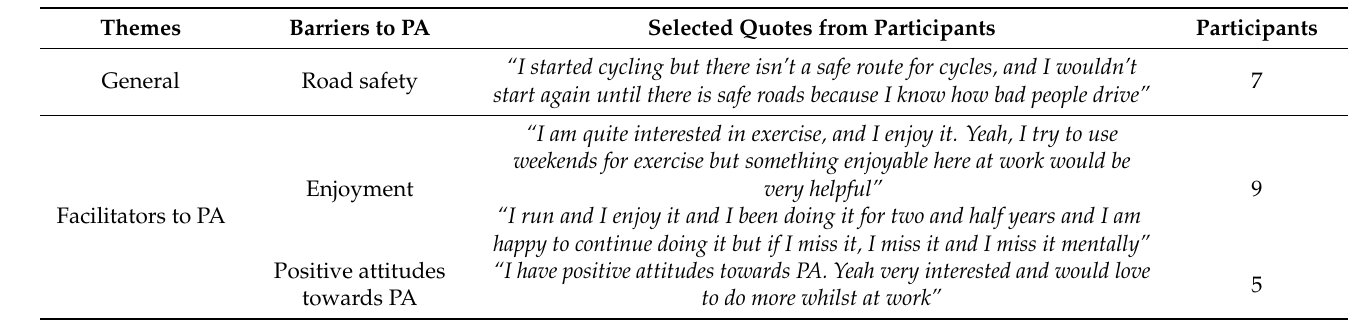
Table 3. A summary of themes and examples of raw data extracts for barriers to and facilitators for PA from active group participants.